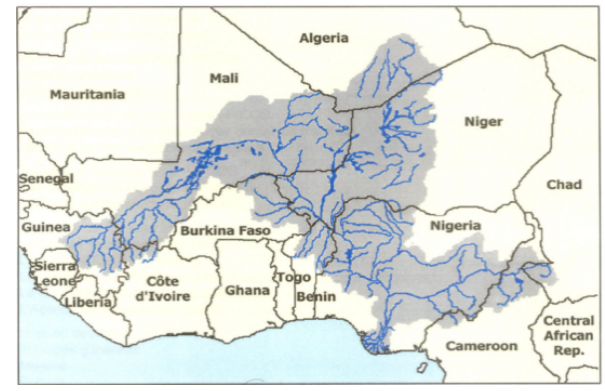
Figure 1. Niger and Benue in West